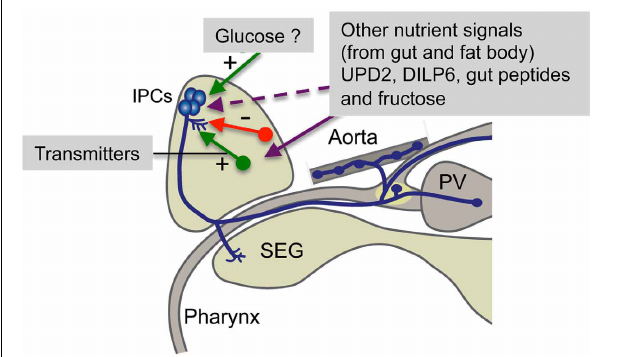
FIGURE 4 | Summary of factors regulating brain IPCs. The brain IPCs are regulated by neurotransmitters (including neuropeptides) from neurons in the brain (red and green arrows) in a stimulatory ( + ) or inhibitory ( − ) fashion. These neurons are in turn likely to be activated by nutritional signals from the circulation, fat body or intestine. Some of these signals may act directly on the IPCs. UPD2 inactivates GABAergic neurons that then relieves tonic inhibition of IPCs (Rajan and Perrimon, 2012) and circulating fructose acts on brain neurons expressing the fructose receptor Gr43a (Miyamoto et al., 2012). Gut peptides include allatostatin A, DH31 and tachykinins (DTKs), known to have receptors on neurons regulating IPCs or directly on IPCs (Johnson et al., 2005; Veenstra, 2009; Birse et al., 2011). Circulating glucose has been proposed to be sensed by IPCs via uptake, entering glycolysis and the resulting ATP blocking ATP-sensitive K + channels on IPCs leading to membrane depolarization and subsequent opening of voltage sensitive Ca 2 + channels (Kreneisz et al., 2010). PV, proventriculus; SEG, subesophageal ganglion. Not shown here is the expression of an adiponectin-like receptor in IPCs (Kwak et al., 2013). This receptor may be targeted by a hitherto unidentified adipokine signal from the fat